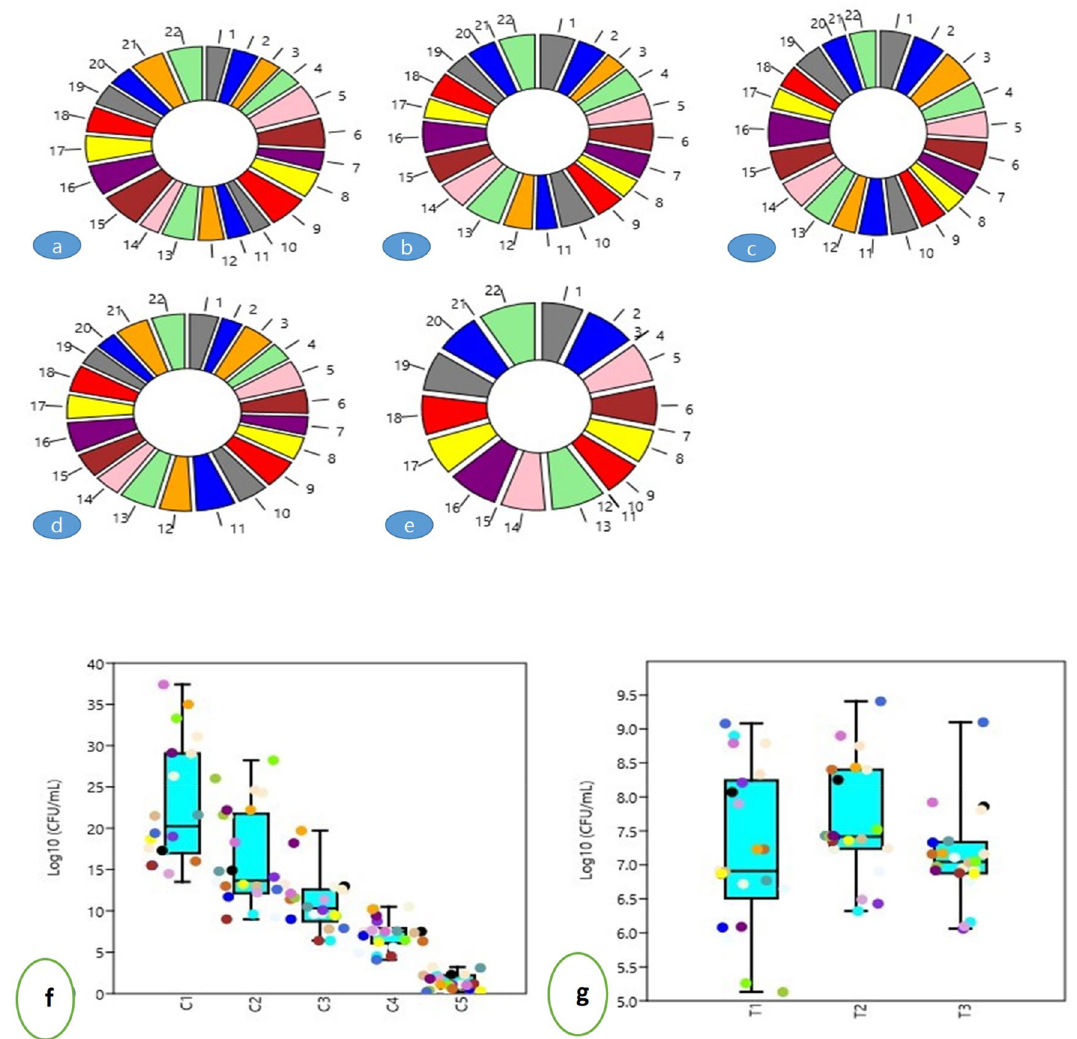
Figure 6. Representation of antibiotic sensitivity of the isolated microflora against [inhibition zone (mm)] ( a ) Chloramphenicol; ( b ) Rifampicin; ( c ) Amikacin; ( d ) Erythromycin and ( e ) Polymyxin-B, the numbers represent: 1: Bacillus foraminis strain skuast2; 2: Enterobacter cloacae strain SKUAST-K4; 3: Bacillus firmus strain SKUAST-K10; 4: Salinivibrio costicola strain SKUAST-K11; 5: Pantoea agglomerans strain SKUAST-K12; 6: Bacillus subtilis smppsap1; 7: Bacillus subtilis smppsap2; 8: Pseudomonas koreensis strain SKUAST-K16; 9: Serratia marcescens strain SKUAST-K24; 10: Comamonas terrigena strain SKUAST-K31; 11: Pseudomonas fragi strain SKUAST-K32; 12: Delftia acidovorans strain SKUAST-K35; 13: Bacillus amyloliquefaciens strain SKUAST-K43; 14: Bacillus subtilis strain SKUAST-K45; 15: Bacillus velezensis strain SKUAST-K46; 16: Bacillus velezensis strain SKUAST-K49; 17: Pseudomonas synxantha strain SKUAST-K50; 18: Pseudomonas fluorescens strain smppsap4; 19: Pseudomonas mucidolens strain SKUAST-K53; 20 : Pseudomonas lurida strain SKUAST-K54; 21: Bacillus pumilus strain smppsap6; 22: Pseudomonas veronii strain SKUAST-K67I; while as Box and Jitter representing ( g ) Variation of bacterial population (log 10 CFU/mL) of the isolated microflora with different concentrations of PEG (C1: 0; C2 :10; C3: 15; C4 :20 and C5 :25% respectively). ( h ) Variation of bacterial population (log10 CFU/mL) of the isolated microflora with different temperature treatments (T1: 15; T2 : 25 and T3 : 35 °C), the symbols represent: Aliceblue: skuast2; Antiquewhite SKUAST-K4; Aqua: SKUAST-K10; Azure SKUAST-K11; Beige : SKUAST-K12; Bisque: smppsap1; Black : smppsap2; Blanchedalmond: SKUAST-K16; Blue : SKUAST-K24; Blueviolet: SKUAST-K31; Brown : SKUAST-K32; Burlywood: SKUAST-K35; Cadetblue : SKUAST-K43; Chartreuse :SKUAST-K45; Chocolate : SKUAST-K46; Yellowgreen : SKUAST-K49; Yellow : SKUAST-K50; Royalblue : smppsap4; Plum : SKUAST-K53; Purple : SKUAST-K54 : Orchid; smppsap6; Orange :